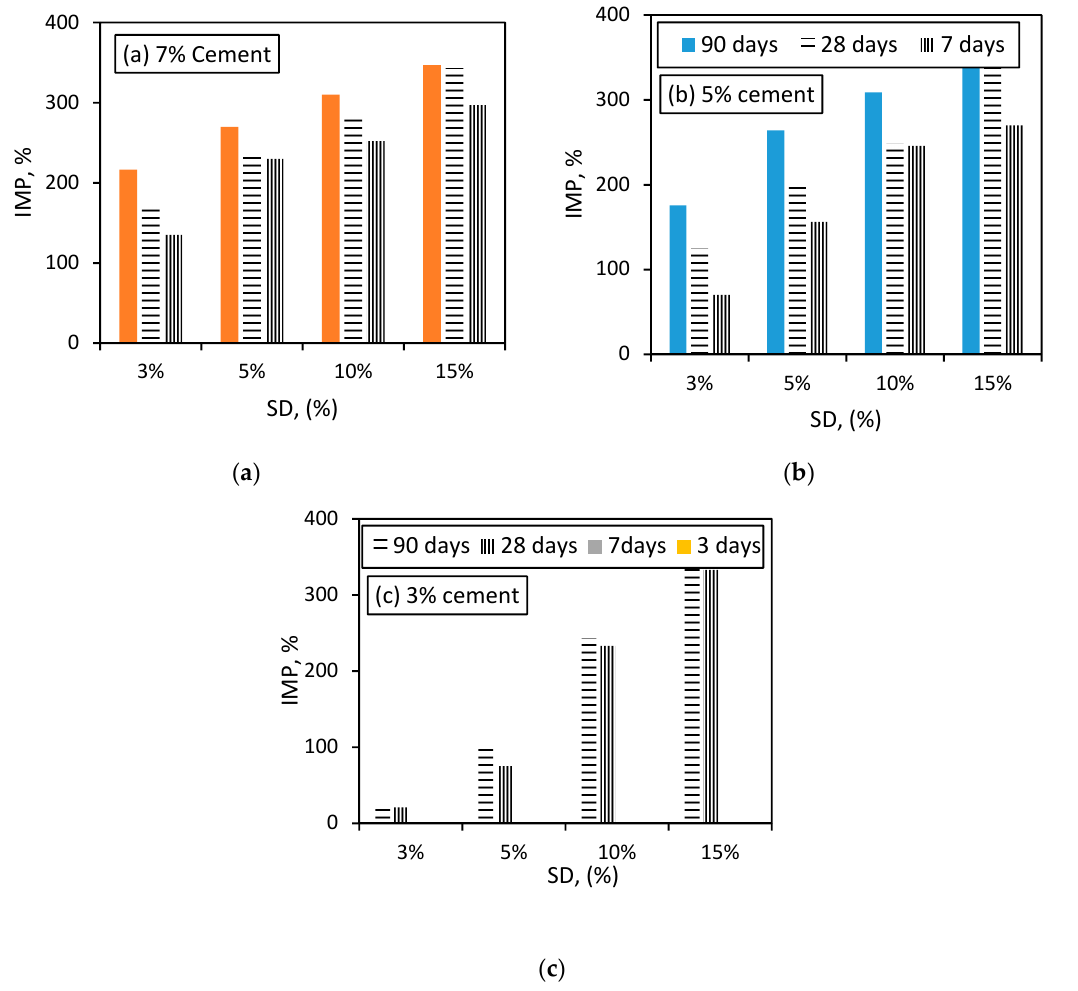
Figure 12. Effect of cement addition on IMP values after exposure to sulphate: ( a ) 7% cement; ( b ) 5% cement; ( c ) 3% cement.